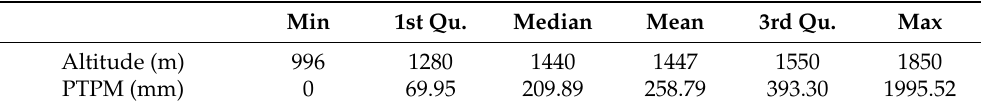
Table 4. Summary statistics PCA for PTPM 1st component.